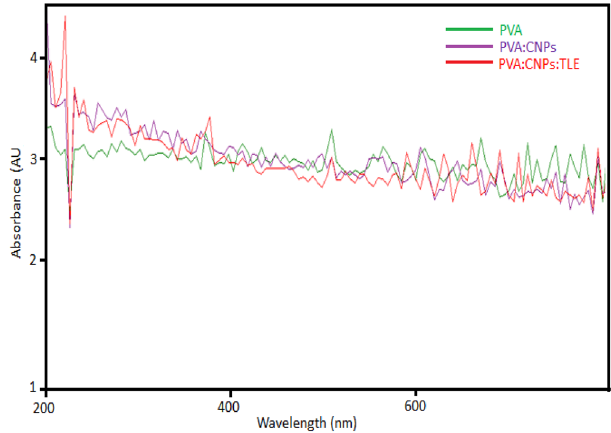
Figure 8. UV absorption spectrum of PVA, PVA: CNPs and PVA: CNPs: